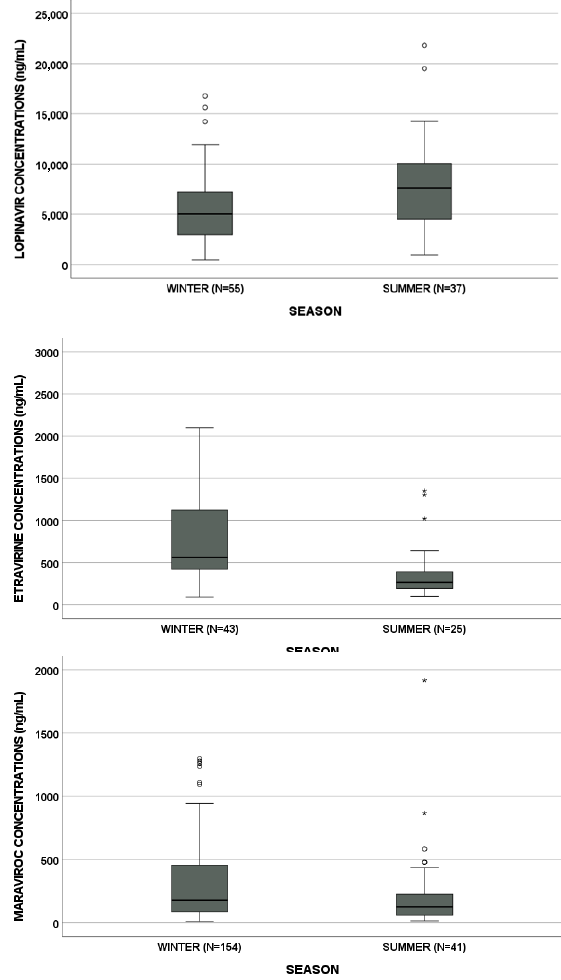
Figure 2. Lopinavir, etravirine and maraviroc levels in winter vs. summer. Circles and stars indicate “out” values (small circle) and “far out” values (star). Table 2. Lopinavir, etravirine and maraviroc median concentrations (ng/mL) in relation to seasonality.